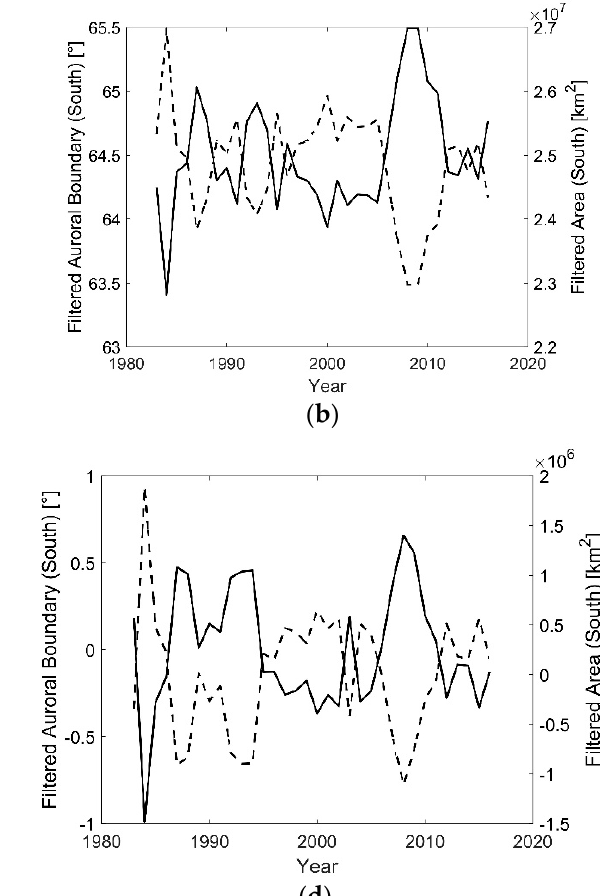
Figure 5. Northern hemisphere filtered AB (°) time variation considering data with QC = 1 and 2 (solid lines) and corre- sponding auroral outer boundary enclosed area A (km 2 ) (dashed lines) using the following filters for AB and A: data for 0 < Kp ≤ 2 ( a ), 2 < Kp ≤ 4 ( b ), 4 < Kp ≤ 6 ( c ), and annual means of residuals from the linear regression with Kp ( d ). Note the different scales.